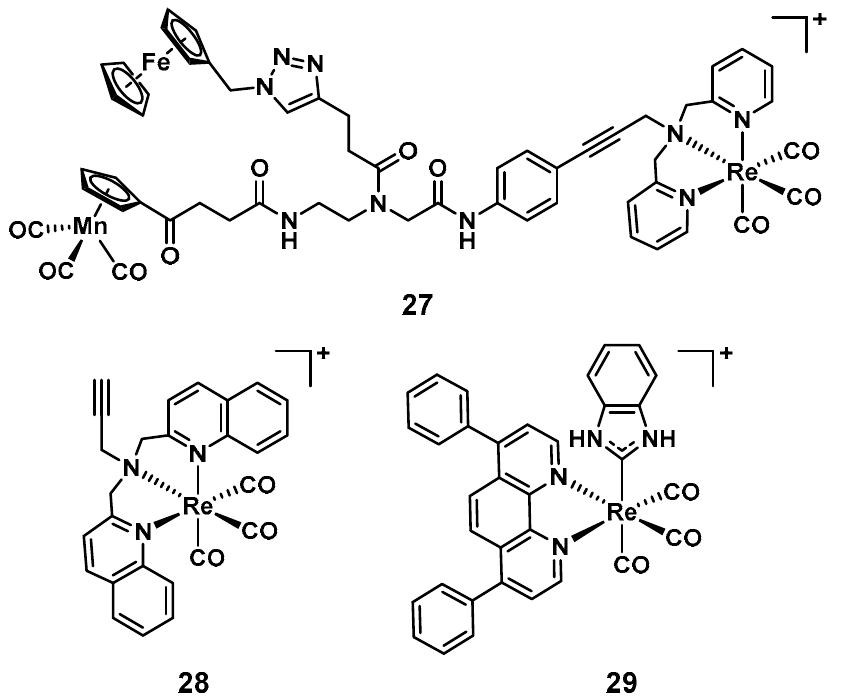
Figure 10. Structures of rhenium complexes with reported antimicrobial activity.